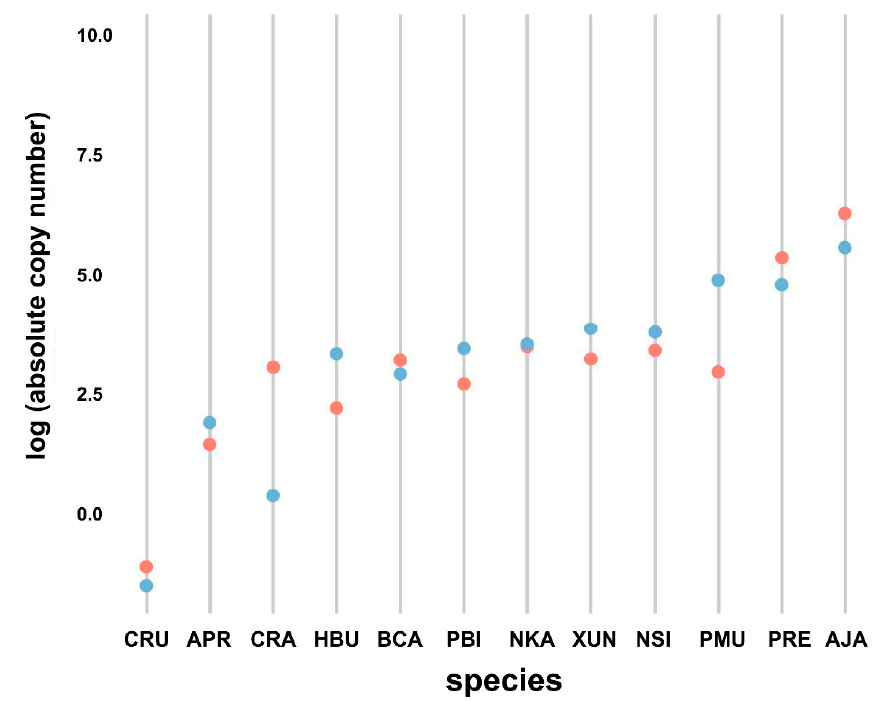
Figure 2. Accumulated copy number of Bov-B LINE retrotransposons in snake species determined by quantitative real-time PCR. Cylindrophis ruffus (CRU), Ahaetulla prasina (APR), Coelognathus radiatus (CRA), Homalopsis buccata (HBU), Bungarus candidus (BCA), Python bivittatus (PBI), Naja kaouthia (NKA), Xenopeltis unicolor (XUN), Naja siamensis (NSI), Ptyas mucosa (PMU), Python regius (PRE), Acrochordus javanicus (AJA). Light blue indicates male. Light red indicates female. 3.5. Comparison of Bov-B LINE Copy Numbers between Males and Females The qPCR method was applied to measure the Bov-B LINE copy number between male and female individuals. Although the Wilcoxon signed-rank test showed no differentiation between sexes in all species (Wilcoxon signed-rank test, W = 687.5, p = 0.08) (Figure 3), males tended to show a higher copy number than females in five species ( X. unicolor , P. bivittatus , H. buccata , A. prasina , and P. mucosa ). By contrast, females tended to show a higher copy number than males in four species ( C . ruffus , P . regius , A . javanicus , and C . radiatus ).